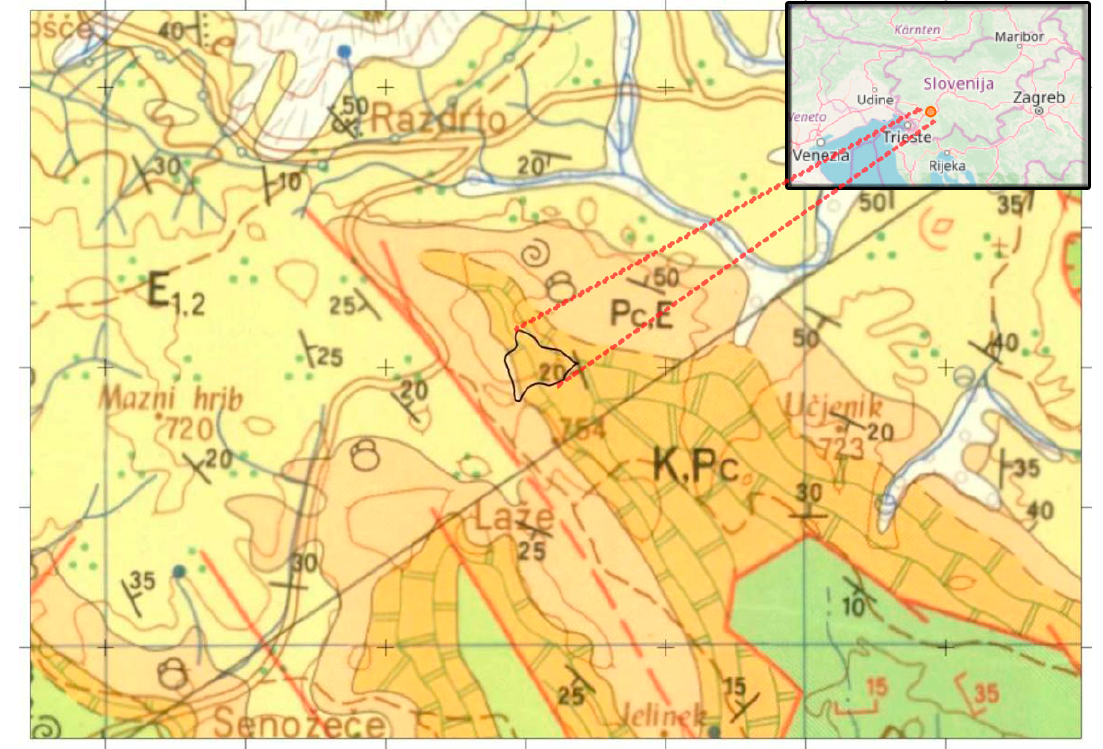
Figure 3. Location of the Laže quarry in the Official geological map of Slovenia (Postojna sheet) (public access on [60]).